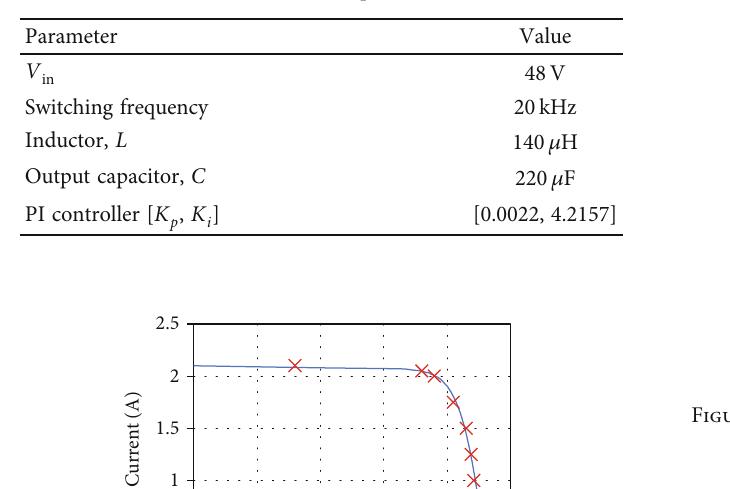
Table 1: Hardware parameters.